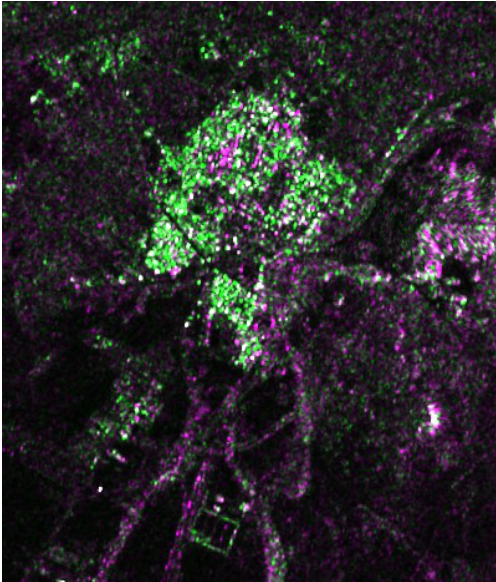
Figure 3. Erfoud town satellite image Sentinel-1 SAR data VH+VV+VH σ0 values RGB colour composite For removing high noise rate of the SAR signal, which comes from rocky area and ridges digital elevation model (DEM) SRTM also was included to data stack (Figure 4). In addition, DEM is used for excluding elevation differences between urbanized areas and others, which occurs due to buildings’ height.